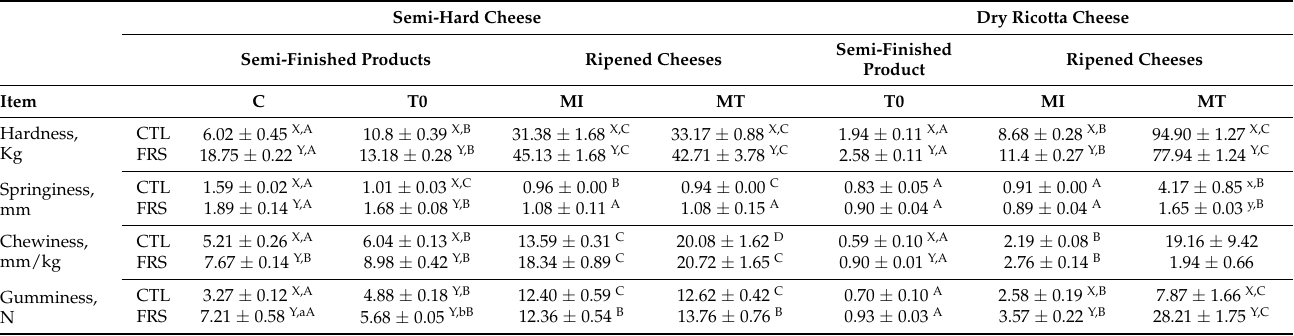
Table 3. Effects of feeding system and ripening time on texture analysis of dry ricotta cheeses and semihard